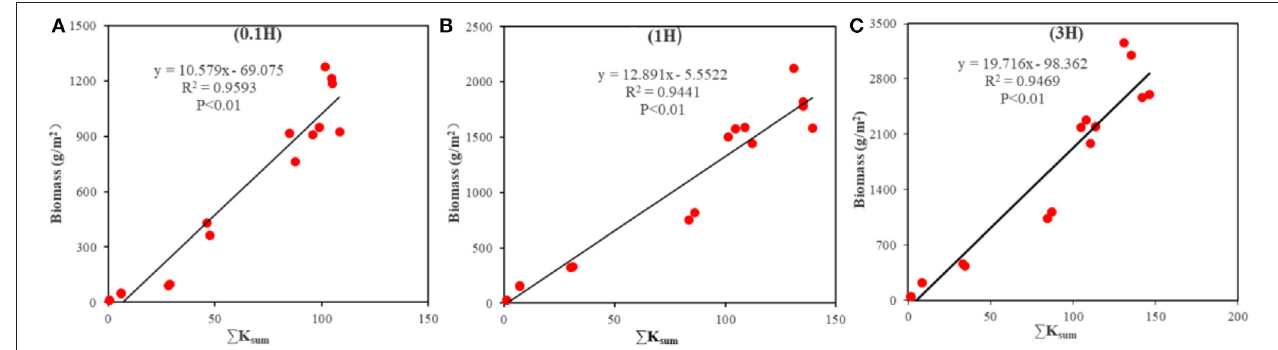
FIGURE 9 | Correlation between biomass and K sum at the sampling points with different distances from the shelterbelt (0.1H, 1H, and 3H). (A) represents the fitting result within 0.1H. (B) represents the fitting result within 1H. (C) represents the fitting result within 3H.